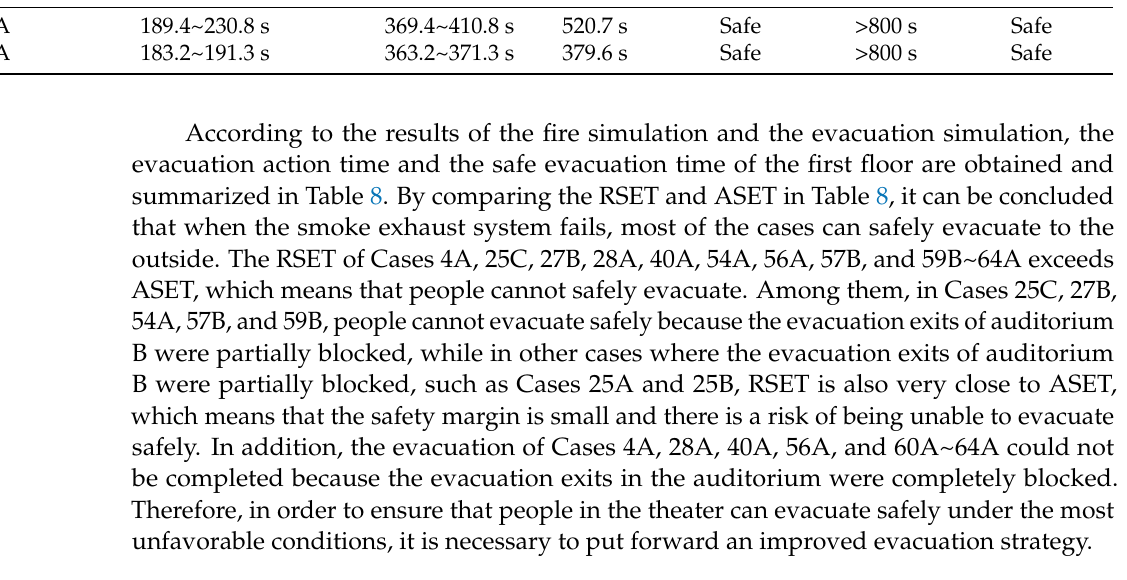
Table 8. ASET and RSET on the first